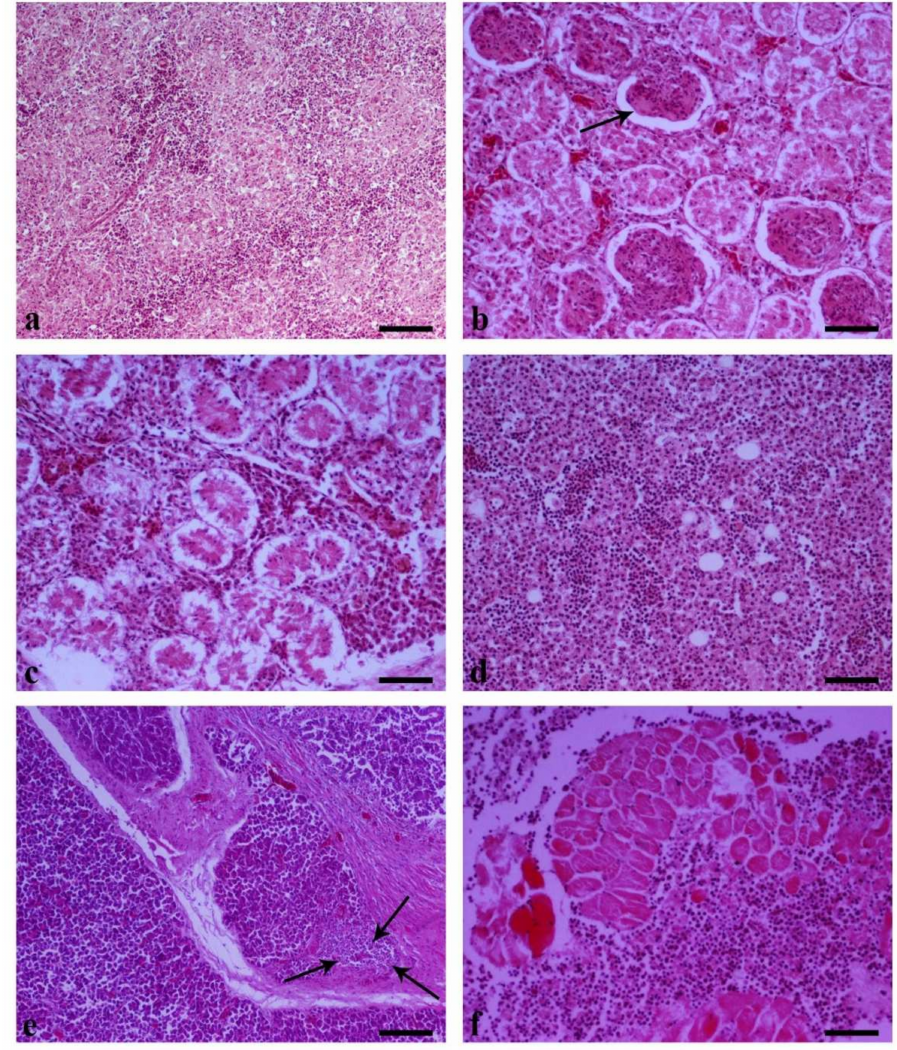
Figure 9. ( a ) Spleen. Intense depletion of lymphoid follicles characterized by prominence of retic- ular cells in the absence of lymphocytes in the germinal center. H–E. Bar, 100 µ m. ( b ) Kidney. Renal glomeruli are hypercellular due to increase in mesangial cell number (mesangio prolifera- tive glomerulonephritis). Note a glomerulus with segmental glomerulosclerosis (arrow). Tubular epithelial necrosis, interstitial hyperemia, and hemorrhage are also observed. H–E. Bar, 50 µ m. ( c ) Kidney. The tubular epithelium is characterized by necrosis, and in the interstitial connective tissue are seen aggregates of mononuclear inflammatory cells. H–E. Bar, 50 µ m. ( d ) Bone marrow. Mild depletion. Sparse cells throughout the bone marrow present nuclear pyknosis and, more often, fragmentation suggesting necrosis of bone marrow. H–E. Bar, 50 µ m. ( e ) Pancreas. Pancreatic lobules present loss of their architecture (absence of acini). The interlobular connective tissue is intensely increased, consisting of fibroblasts and collagen fibers, and is infiltrated by a few mononuclear cells. Additionally, a lobule reveals a large aggregate of mononuclear cells to its lower right side (arrows) H–E. Bar, 100 µ m. ( f ) Skeletal muscle. Degeneration and necrosis of muscle fibers and infiltration of the perimysium and endomysium with mononuclear cells and heterophils. H–E. Bar, 50 µ